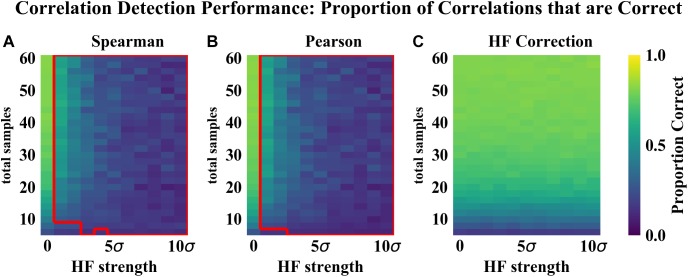
Correlation detection performance for simulated data: proportion of detected correlations that are correct. Heat map colors represent the mean proportion of correct correlations based on 50 simulated data sets for each combination of HF strength and sample size. (A) Spearman correlations. (B) Pearson correlations. (C) HF correction. Red box in (A,B) indicates the set of conditions (HF strength and sample size) for which there was a statistically significant improvement for HF correction compared to the other method tested.